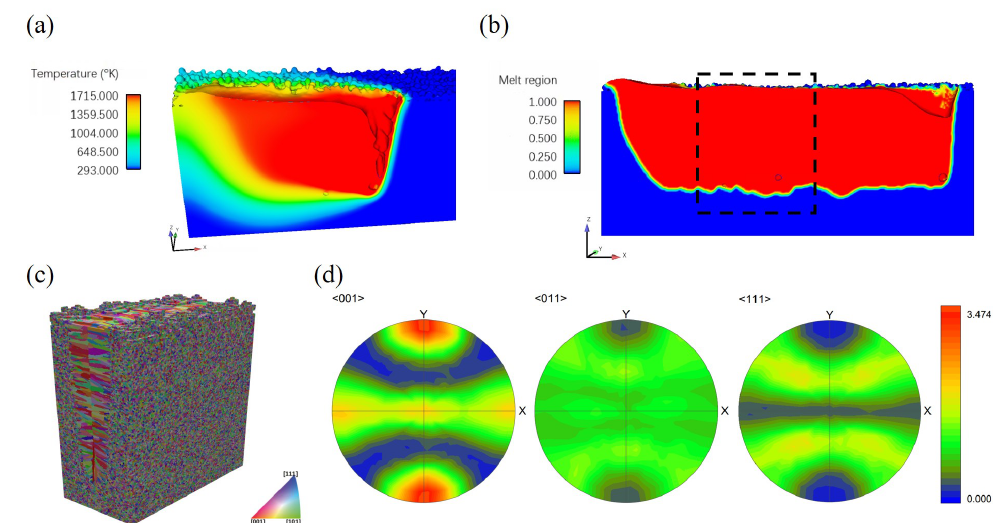
Figure 23. Keyhole-mode melting simulation results: ( a ) deep and narrow melt pool, ( b ) fusion zone with pore defects, where the black dashed line outlines the region for CA simulation, ( c ) 3D view of the microstructure simulation result, ( d ) pole figures of solidification grain structure within the fusion